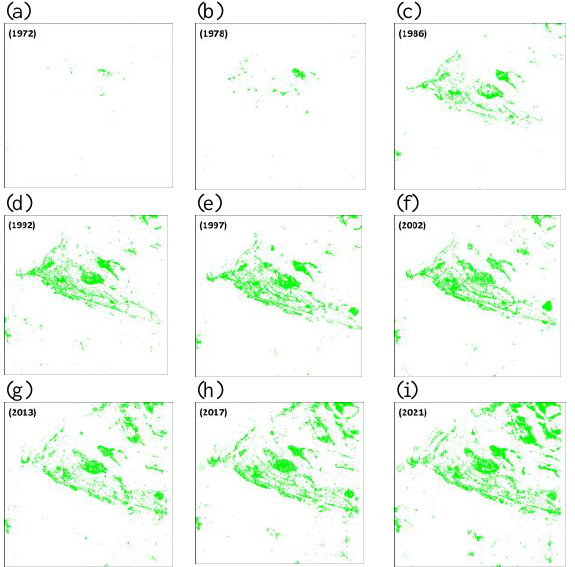
Figure 2 . Vegetation cover changes in Abu Dhabi during the study period (a) 1972, (b) 1978, (c) 1986, (d) 1992, (e) 1997, (f) 2002, (g) 2013, (h) 2017, and (i) 2021.